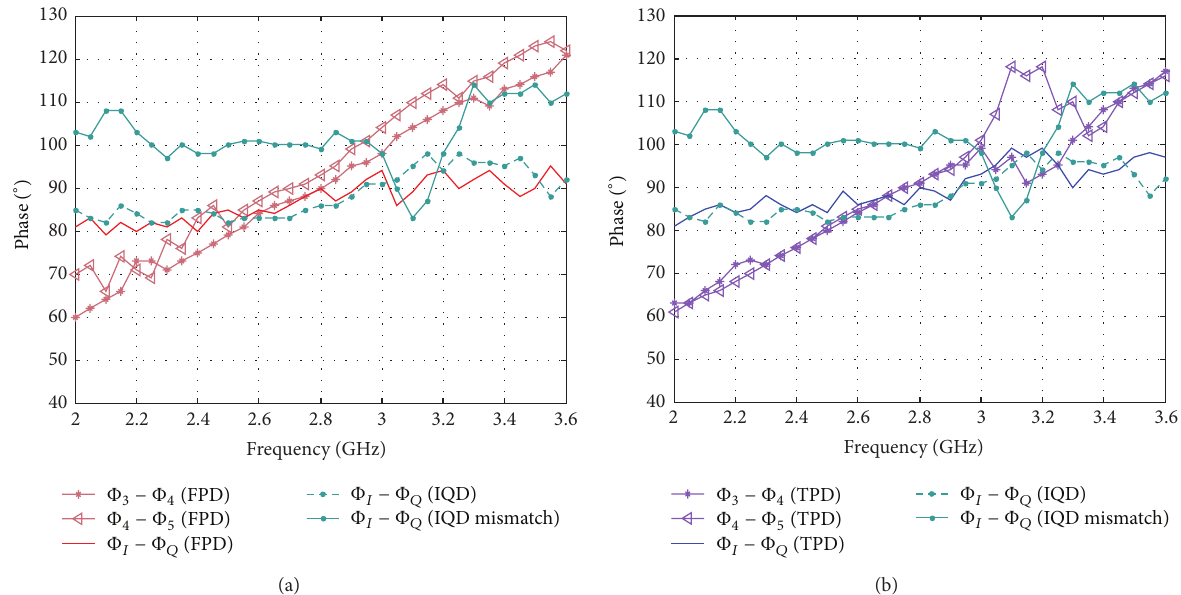
(𝑡) and 𝑄 (𝑡) OUT OUT